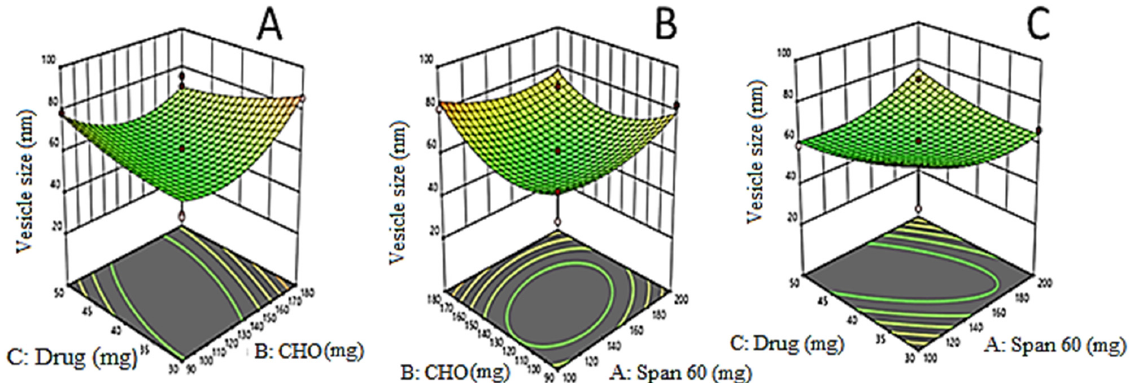
Figure 1. ( A – C ): 3D ‐ Response surface plots demonstrating the influence of independent variables i.e., amount of span 60 (X 1 ), amount of cholesterol (X 2 ) and amount of drug (X 3 ) on VZ (nm) of EZL ‐ PNs.